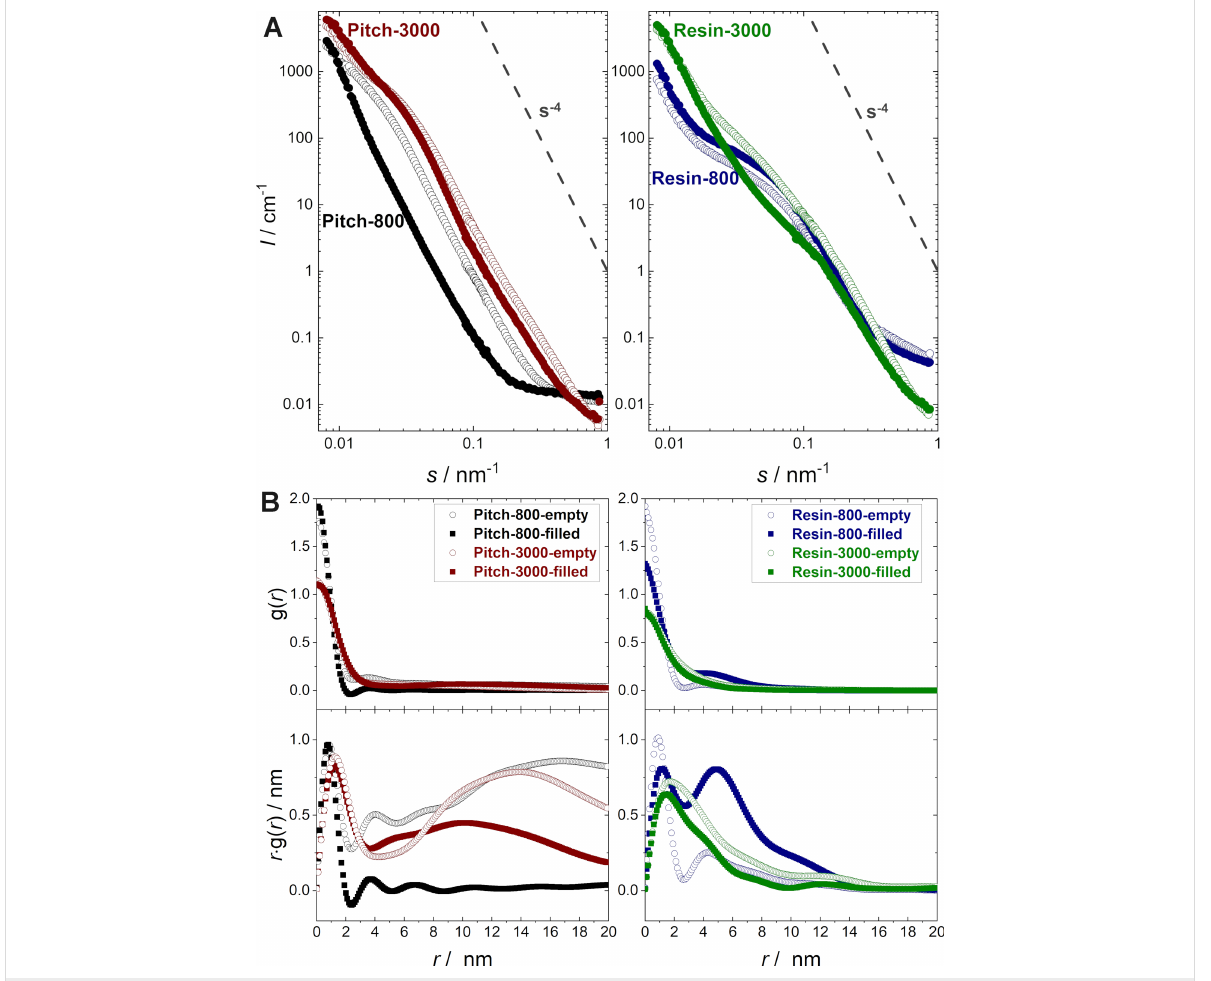
Figure 1: Figure 4 in the original article: SANS raw data (A) and CLD analysis (B) for the four resin- and pitch-based carbon materials, treated at 800 °C and 3000 °C. For all samples, SANS analysis was performed on evacuated samples (hollow symbols), as well as under a maximum load of deuterated p -xylene (filled symbols). All samples exhibit a Porod-asymptote ( s − 4 ) at large s (modulus of the scattering vector), proving an almost ideal two-phase system (pore–carbon) with sharp interfacial boundaries on the nanometer scale.